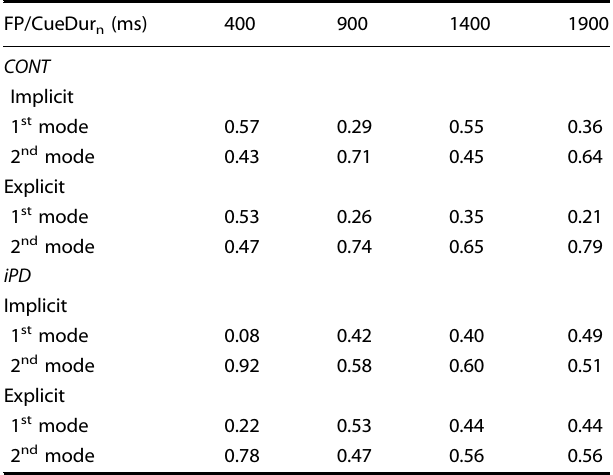
Table 3. Mixing proportions of 1 st and 2 nd mode responses.